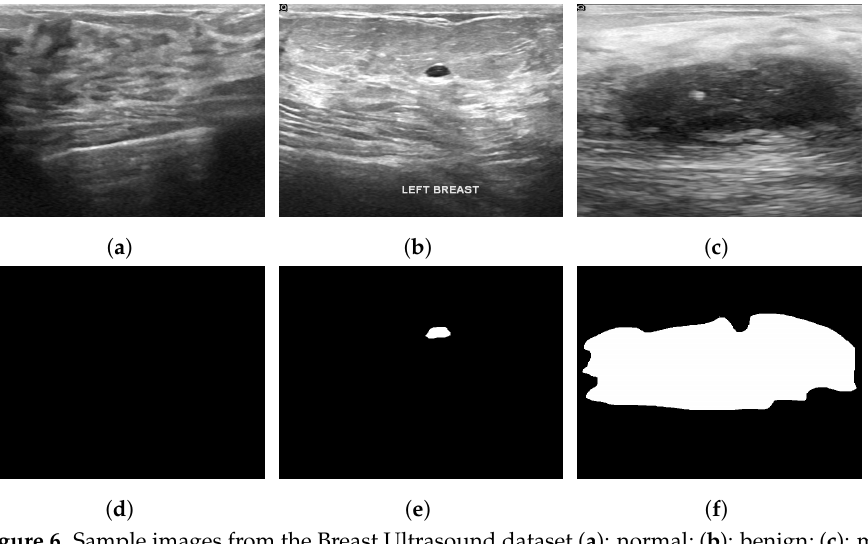
Figure 6. Sample images from the Breast Ultrasound dataset ( a ): normal; ( b ): benign; ( c ): malignant; ( d ): ground truth—normal; ( e ): ground truth—benign; ( f ): ground